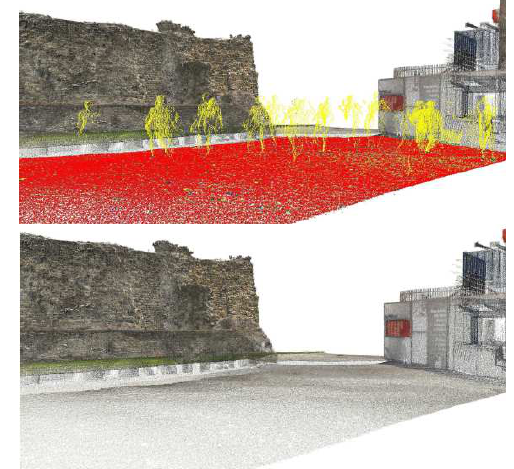
Figure 2. People filtering in laser